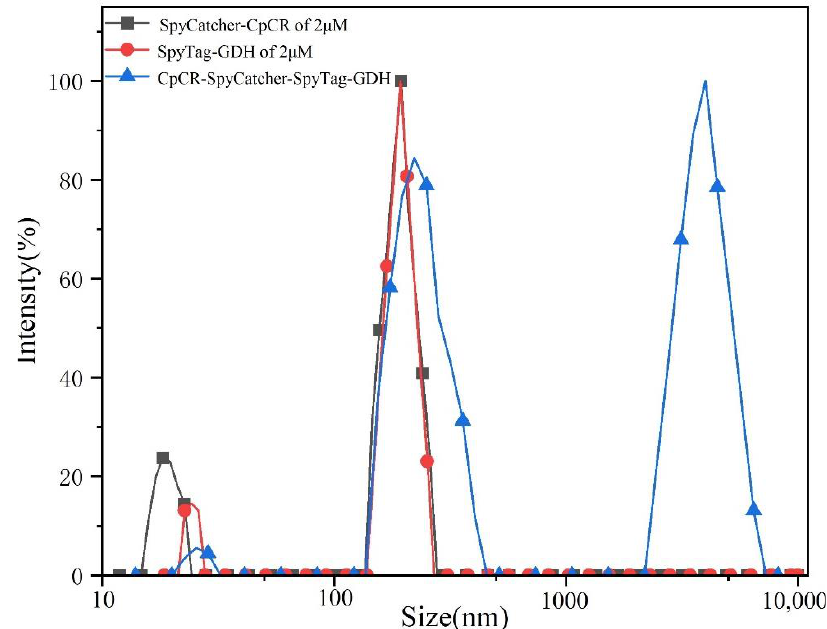
Figure 14. DLS analysis of